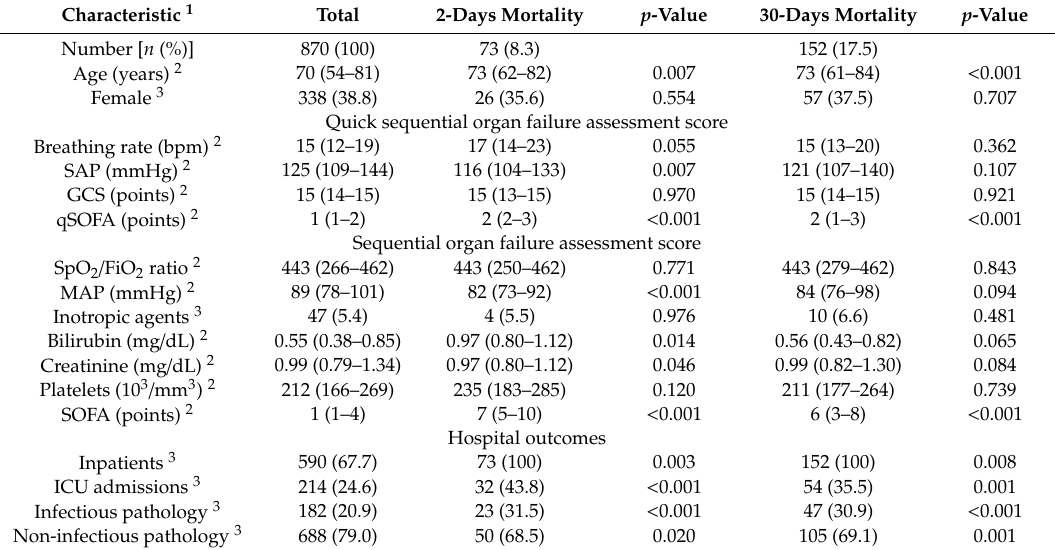
Table 3. Demographic, clinical and hospital outcomes of included